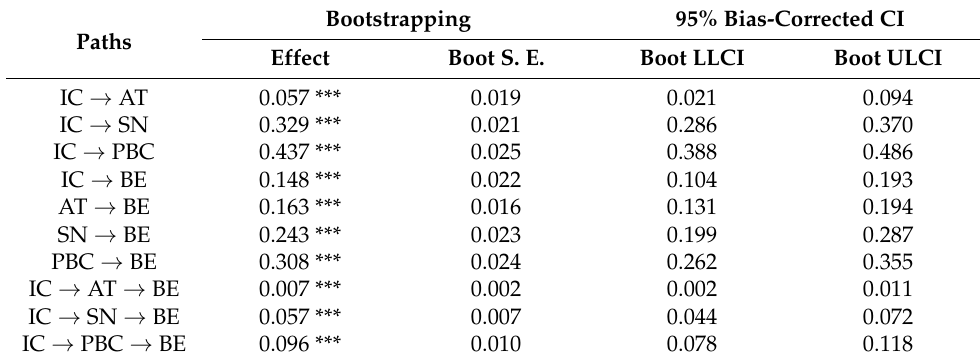
Table 5. Results of